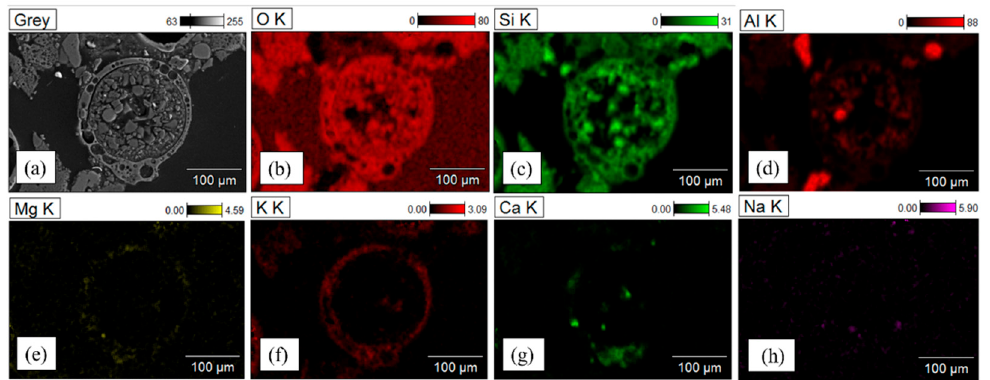
Figure 5. SEM/BSE image ( a ) of cenospheres in the Thermacoat™ and accompanying maps repre- senting the distribution of O ( b ), Si ( c ), Al ( d ), Mg ( e ), K ( f ), Ca ( g ), and Na ( h ); the latter are the main constituents of cenospheres.